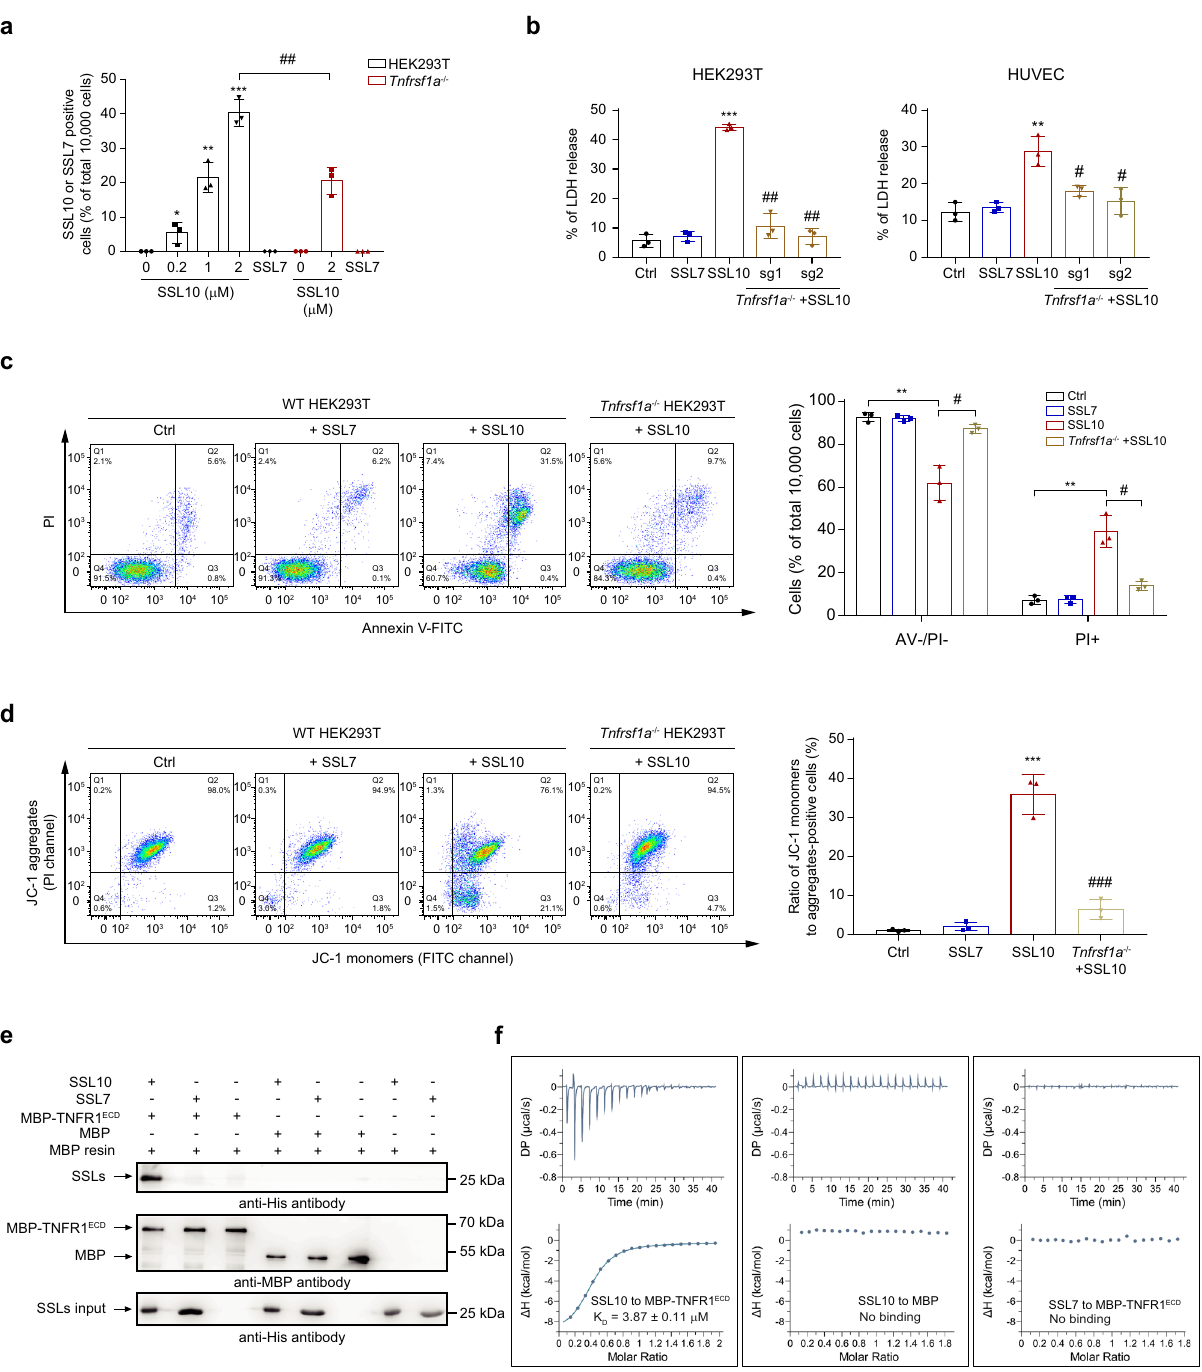
Fig. 4 SSL10 induces necroptosis by direct interacting with the extracellular domain of TNFR1 (TNFR1 ECD ). a Wild type (WT) or Tnfrsf1a knockout (KO) HEK293T cells were treated with SSL10 at different concentrations for 30 min, and the SSL proteins bound to the cell surface were detected by fl ow cytometry after FITC-conjugated anti-His-tag antibody staining. b WT or Tnfrsf1a KO cells were treated with 2 μ M SSL10 for 48 h at 37 °C and 5% CO 2 , and the LDH release was detected. c WT or Tnfrsf1a KO HEK293T cells were challenged with 2 μ M SSL10 for 48 h and the cell viability was measured by fl ow cytometry after Annexin V/PI staining. The dot plot (left) is representative of three independent experiments, and the results of quanti fi cation (right) are shown as a bar graph. d Depolarization of the mitochondrial membrane of WT or Tnfrsf1a KO HEK293T cells treated with SSL10 was measured by fl ow cytometry after JC-1 staining. The dot plot (left) is representative of three independent experiments, and the results of quanti fi cation (right) are shown as a bar graph. e Immunoblotting of SSL10 after pull-down with MBP-TNFR1 ECD . f ITC assays for SSL10 binding to MBP-TNFR1 ECD or MBP control protein. Cells treated with 2 μ M SSL7 were used as a negative protein control throughout the experiments. All data are presented as the means ± SD from three independent experiments. * p < 0.05; ** p < 0.01; *** p < 0.001 compared to the Ctrl cells (buffer-treated cells). # p < 0.05; ## p < 0.01; ### p < 0.001 compared to the SSL10 treated group, by two-way